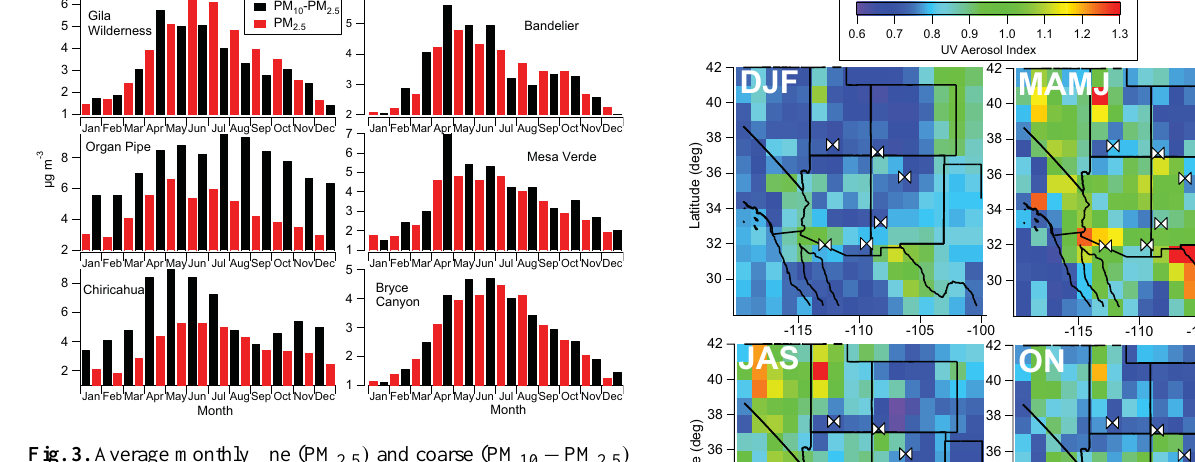
Fig. 3. Average monthly fine (PM 2 . 5 ) and coarse (PM 10 − PM 2 . 5 ) aerosol mass concentrations at six EPA IMPROVE sites. These re- sults are based on data ranges shown in Table 1 for each site.